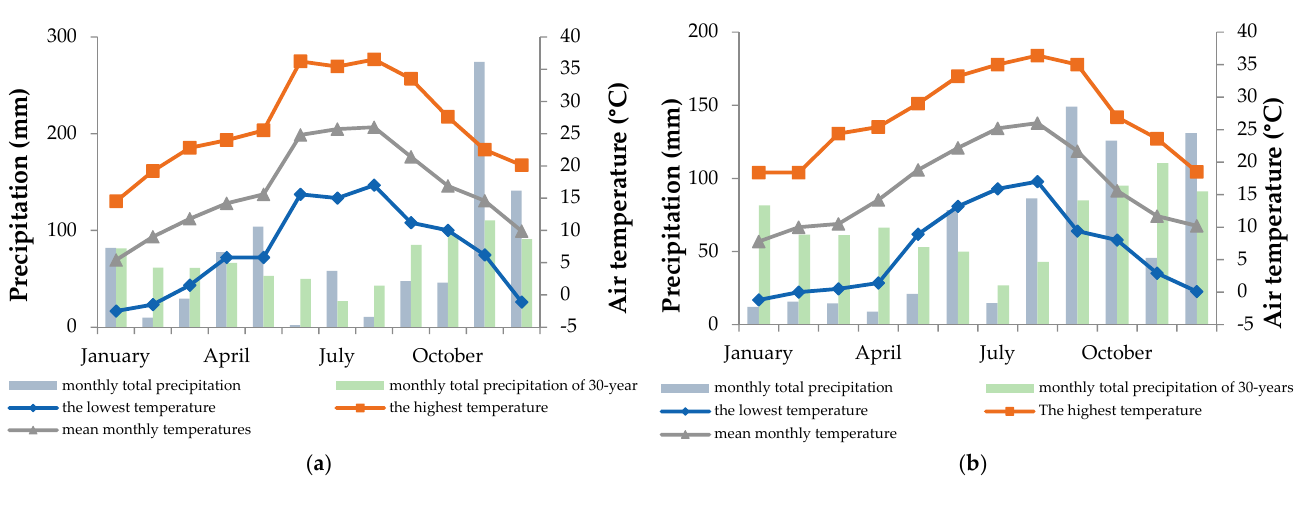
Figure 1. Meteorological conditions in Sikovo: ( a ) 2019; ( b ) 2020.